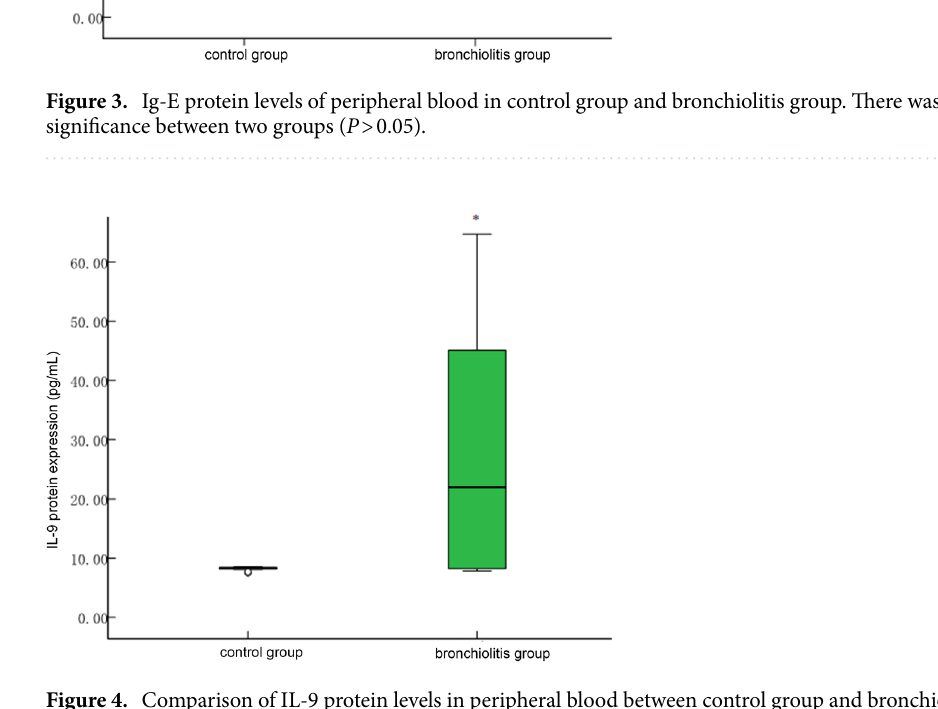
Figure 4. Comparison of IL-9 protein levels in peripheral blood between control group and bronchiolitis group. The protein expression level of IL-9 in bronchiolitis group was higher than control group (* P <